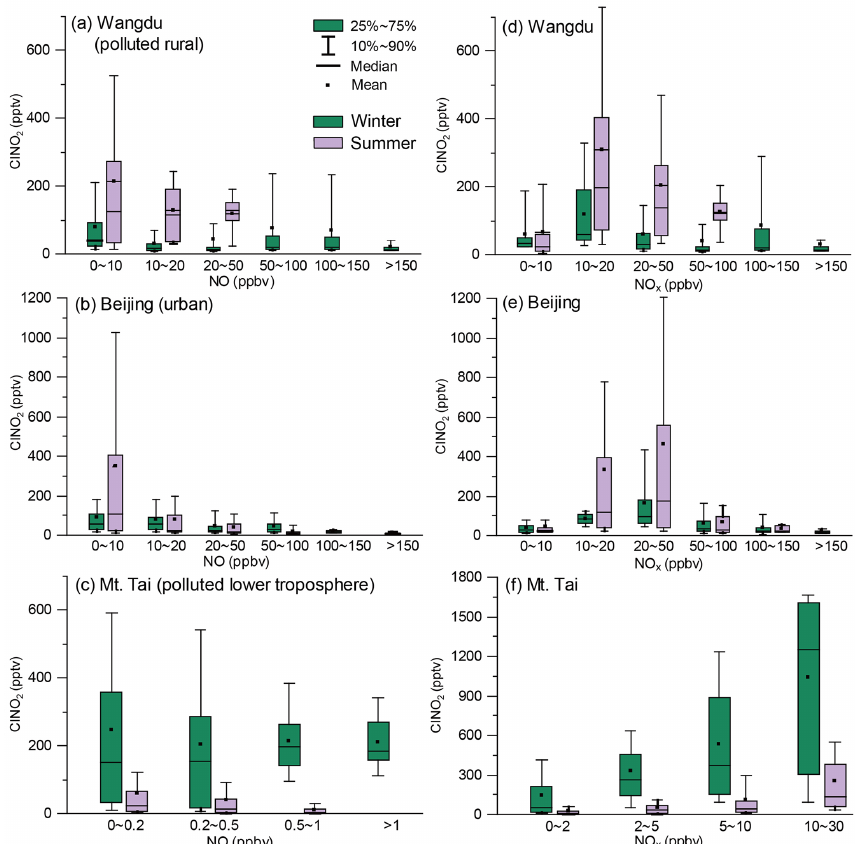
Figure 3. The relationship between nighttime levels of ClNO 2 and grouped NO (a, b, c) and NO x (d, e, f) mixing ratios in the winter (green color) and summer (purple color) campaigns. The difference in the scale of ClNO 2 in (c) and (f) is caused by statistic factors, since only the 10th to 90th percentiles of ClNO 2 data are shown